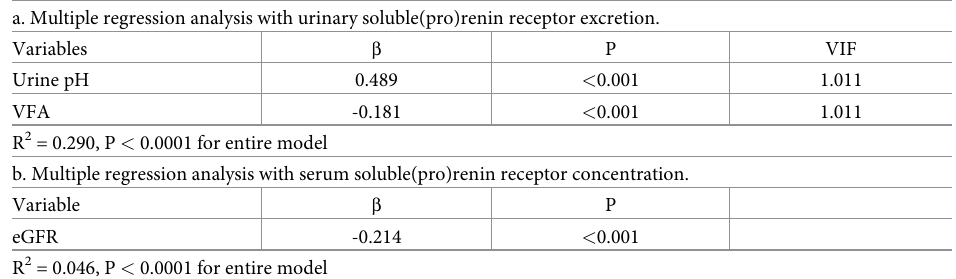
Table 3. Multiple regression analyses. a. Multiple regression analysis with urinary soluble(pro)renin receptor